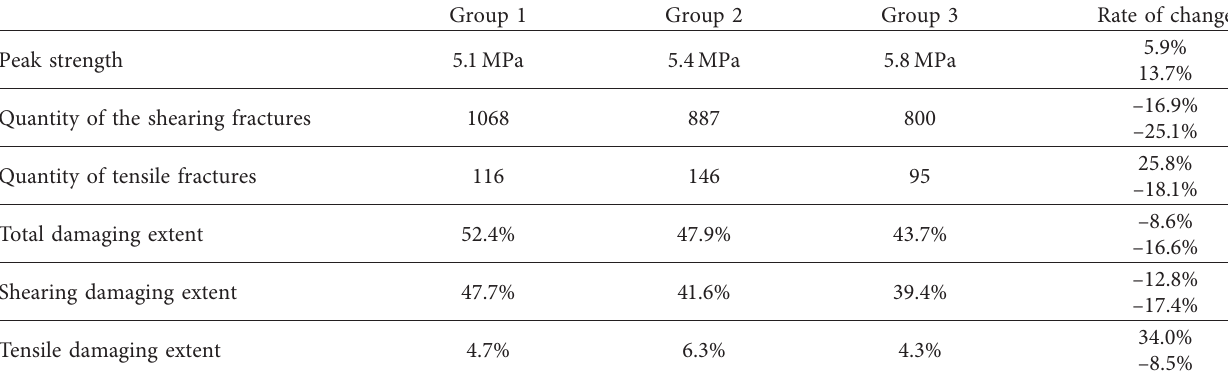
Table 6: Comparison of the stress and fractures in the anchorage